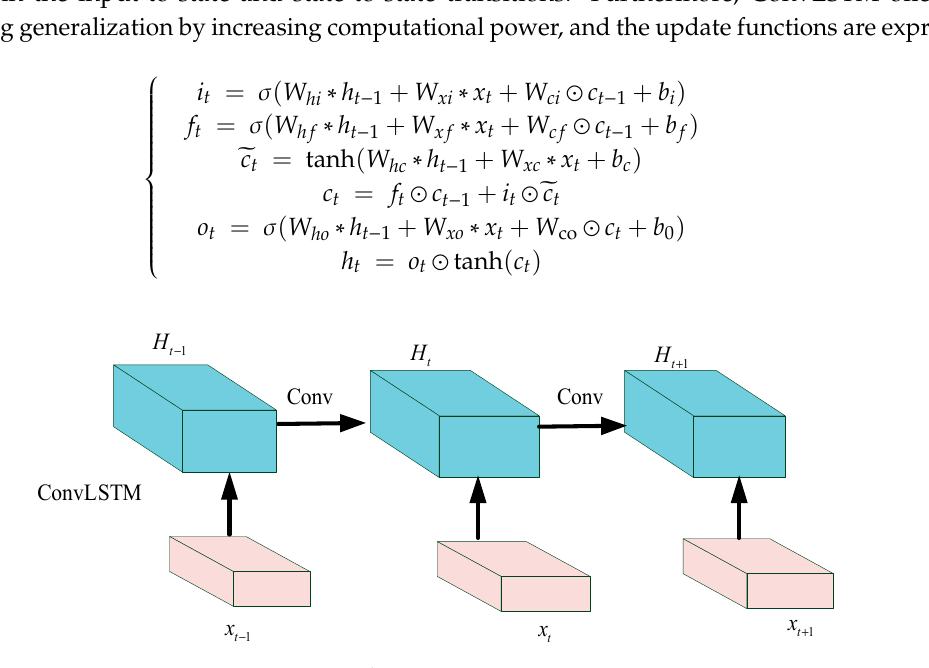
Figure 2. The ConvLSTM structure.